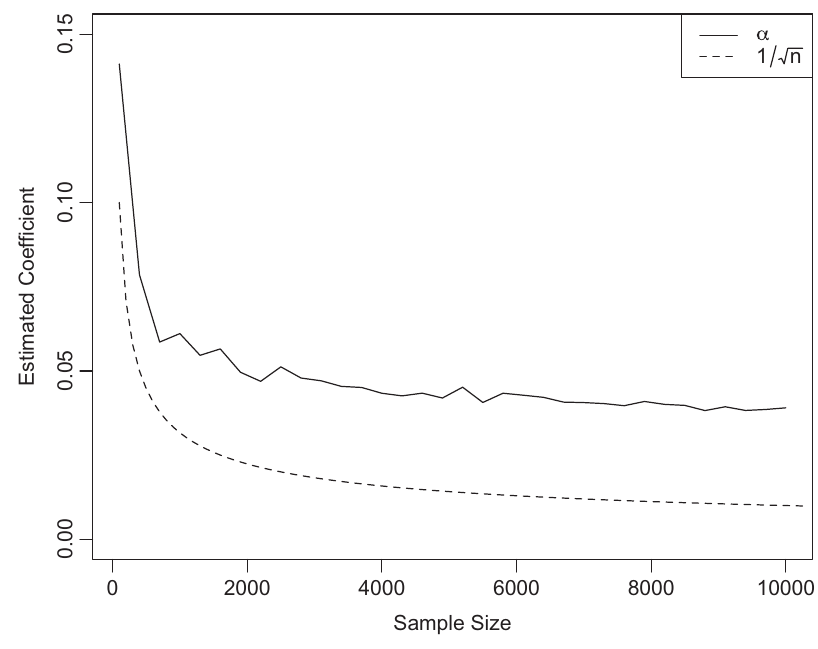
Figure 2: Performance of the modified objective function based estimator for different sample sizes n . √ n and the estimated coefficient (cid:2) ! using the modified objective The dashed and solid lines are 1/